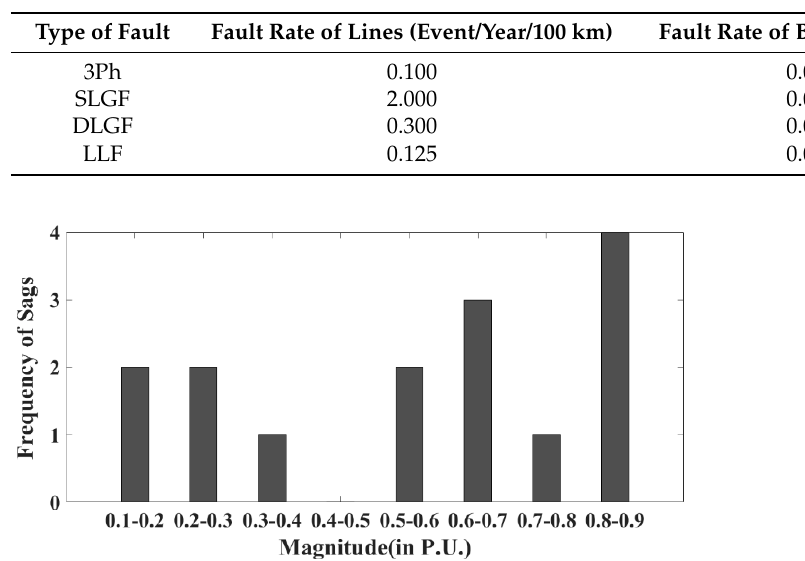
Figure 11. Assessment and comparison of voltage sag per year versus magnitude range of bus 10.